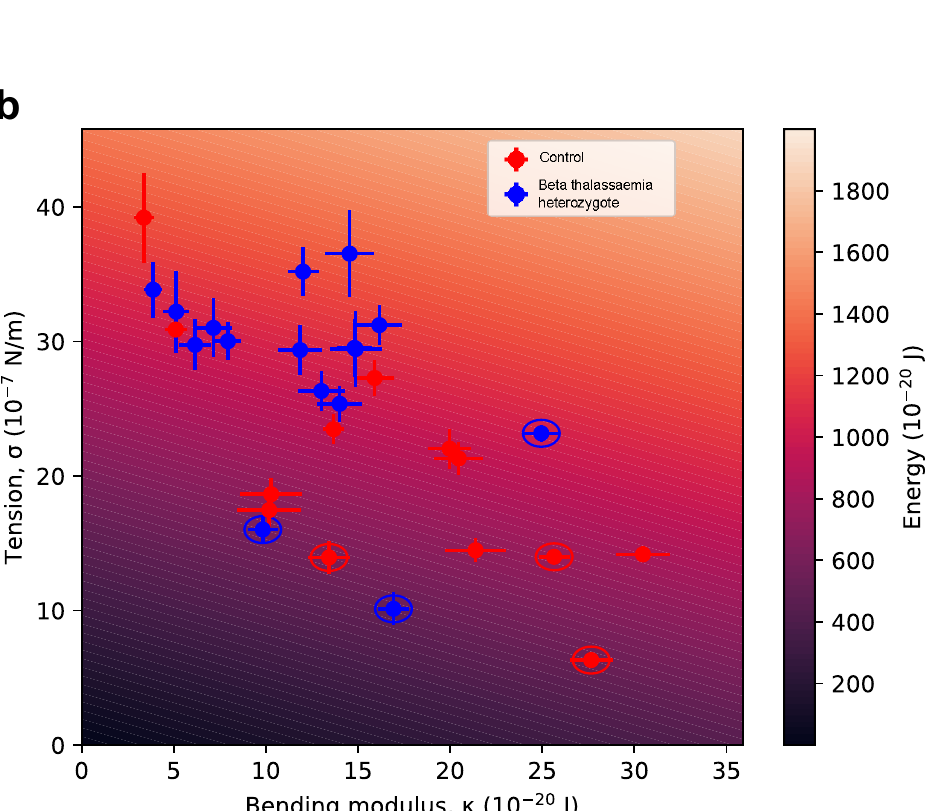
Figure 2. Wrapping energy in beta thalassaemic erythrocytes. Panel ( a ) shows a cartoon of the merozoite (orange) of radius R approaching the erythrocyte (red) and the subsequent deformation. In the top, sequentially from left to right, we see that the merozoite attachment precedes a localised wrapping of the erythrocyte membrane around it. In the lower two panels, the same process is magnified and the geometry emphasised. The patch of membrane which is involved in wrapping is modelled first as a disc of radius R, and following wrapping as a half-sphere of the same radius. Such a deformation requires work, as it involves both bending and stretching of the erythrocyte membrane. Panel ( b ) shows the wrapping energy, which is a function of both bending modulus and stiffness. The heatmap shows the form of this function, with the intensity of background shading representing different wrapping energy, which changes dynamically as tension and bending modulus change. The wrapping energy was also calculated for each individual sample using the data generated in Fig. 1. The error bars are the standard error of the mean for each sample. 2019 samples are